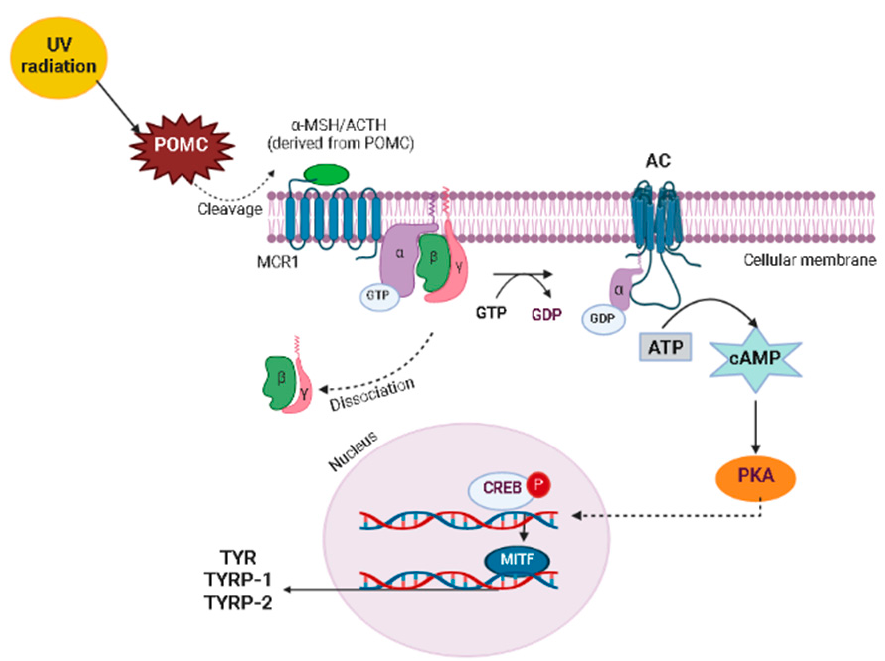
Figure 5. Signaling pathway MITF expression. α -MSH, melanocyte-stimulating hormone; AC, adenylyl cyclase; ACTH, adrenocorticotropic hormone; ATP, adenosine triphosphate; cAMP, cyclic adenosine monophosphate; CREB, cAMP response element; GDP, guanosine diphosphate; GTP, guanosine triphosphate; MCR1, melanocyte-specific melanocortin-1receptor; MITF, microphthalmia-associated transcription factor; PKA, protein kinase A; POMC, pro-opiomelanocortin; TYR, tyrosinase; TYRP-1, tyrosinase-related protein-1; TYRP-2, tyrosinase-related protein-2. The illustration was drawn using Biorender software.